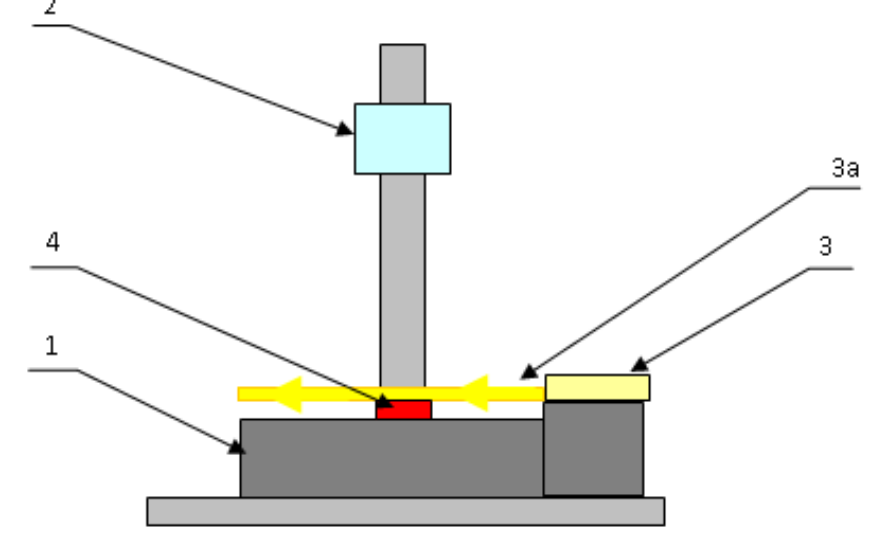
Figure 1. The laboratory stand for image